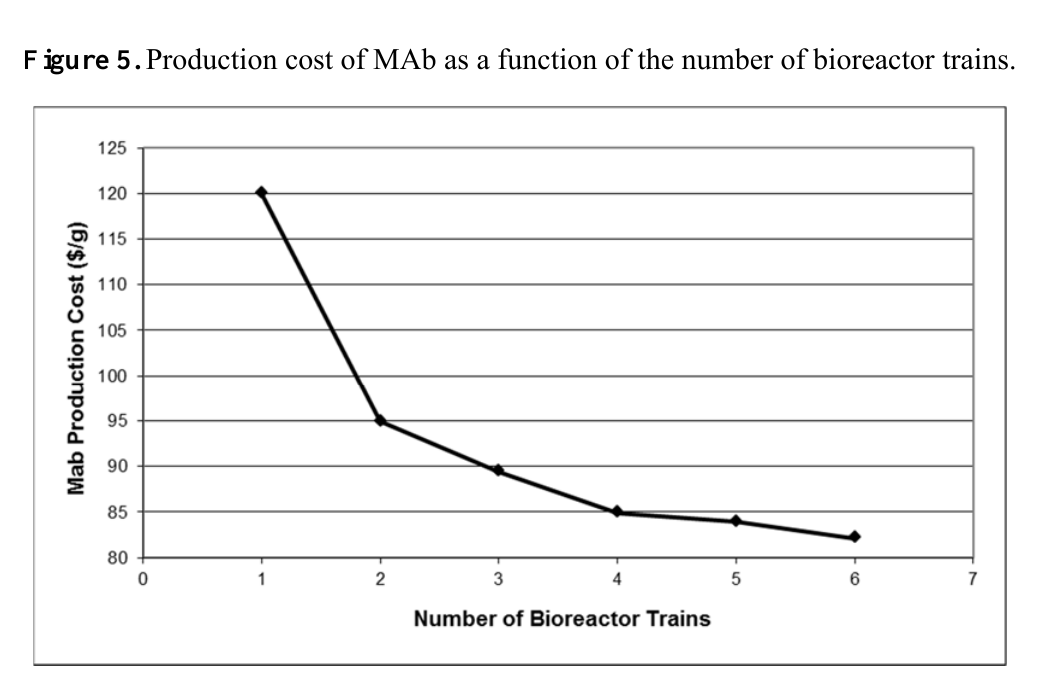
Figure 6. Production cost of MAb as a function of product titer and production bioreactor